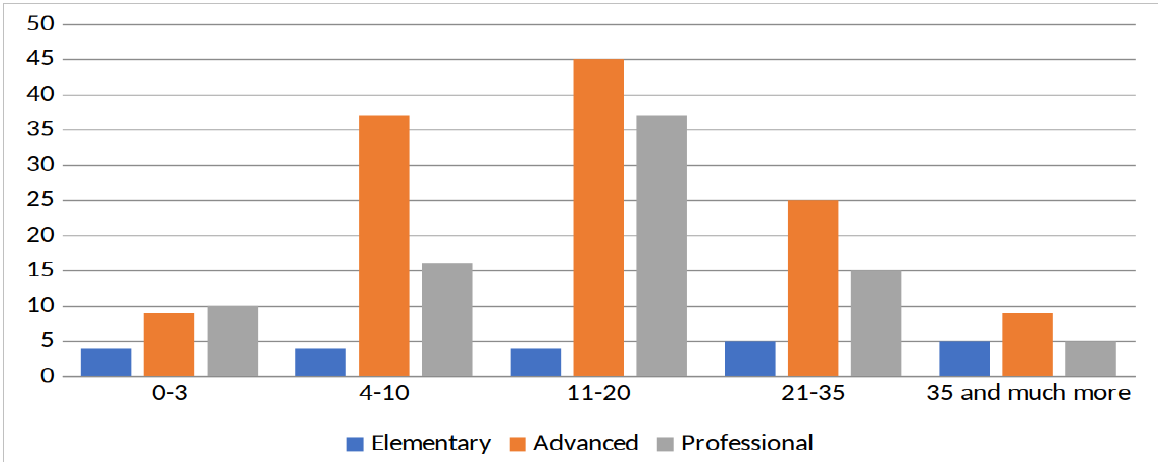
Figure 2. Levels of the E-learning Implementation in the War Time in Ukraine (image developed by the authors).